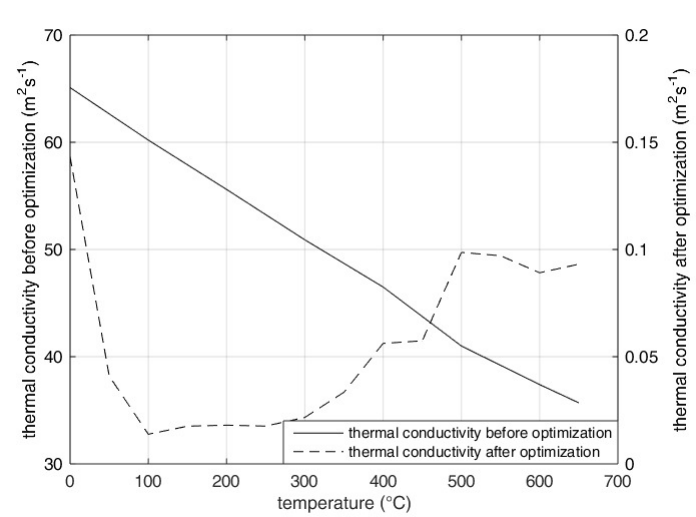
Figure 13. Thermal conductivity behavior before and after